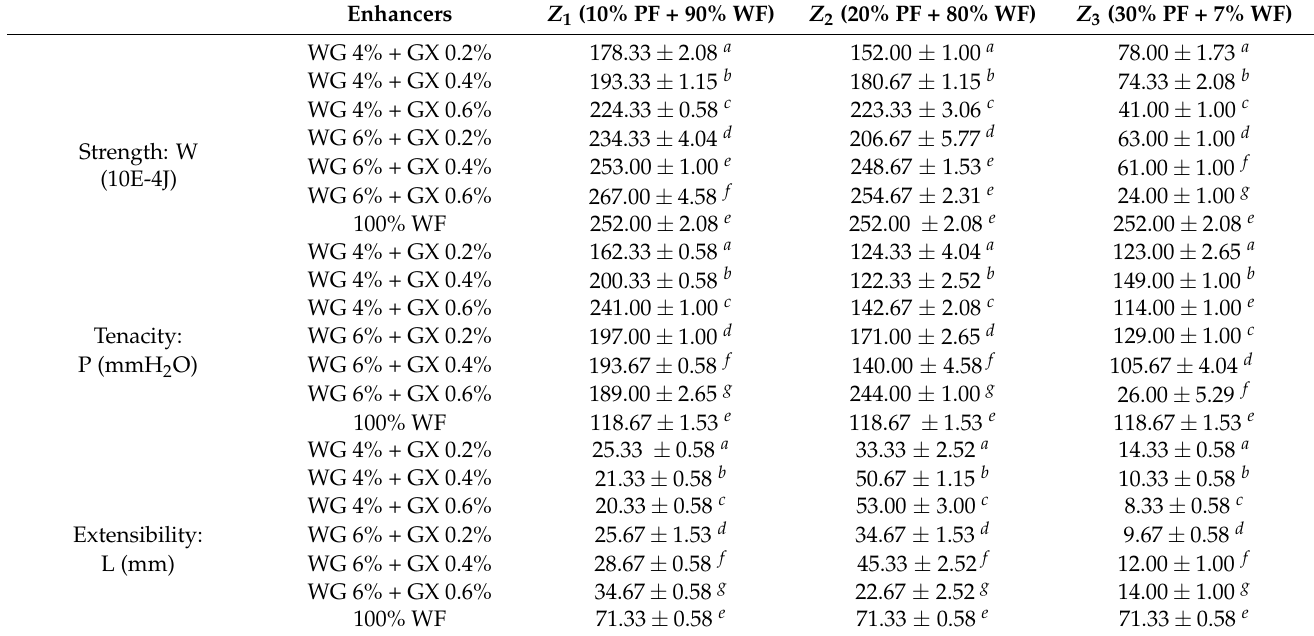
Table 2. Multivariate analysis on the treatments for the formulations.